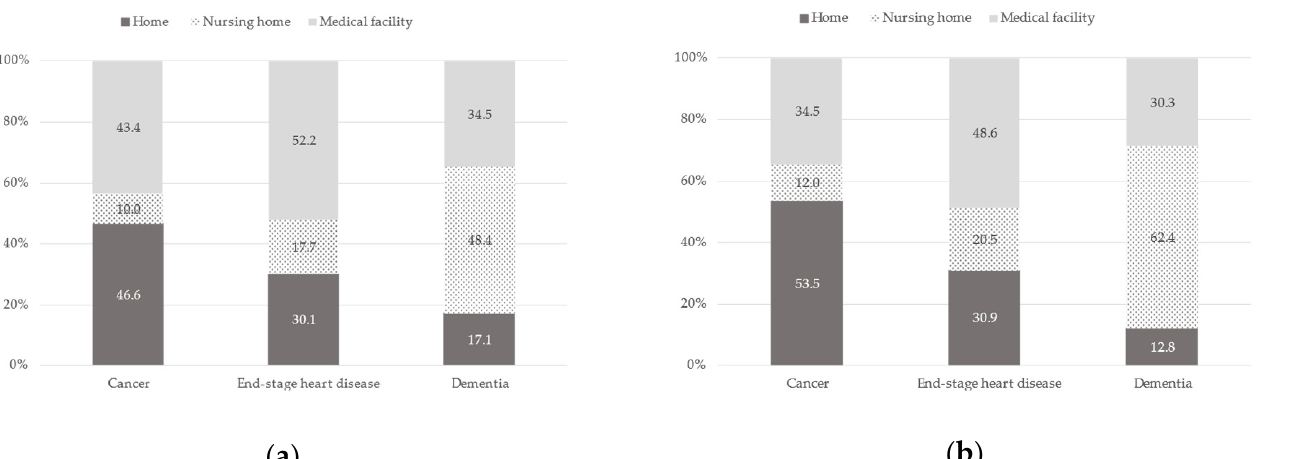
Figure 4. Proportion of preferred place of care by assumed clinical scenario stratified by sex: ( a ) Men ( n = 498); ( b ) Women ( n = 391). Likelihood-ratio test: p = 0.21, Wald test: p = 0.06.